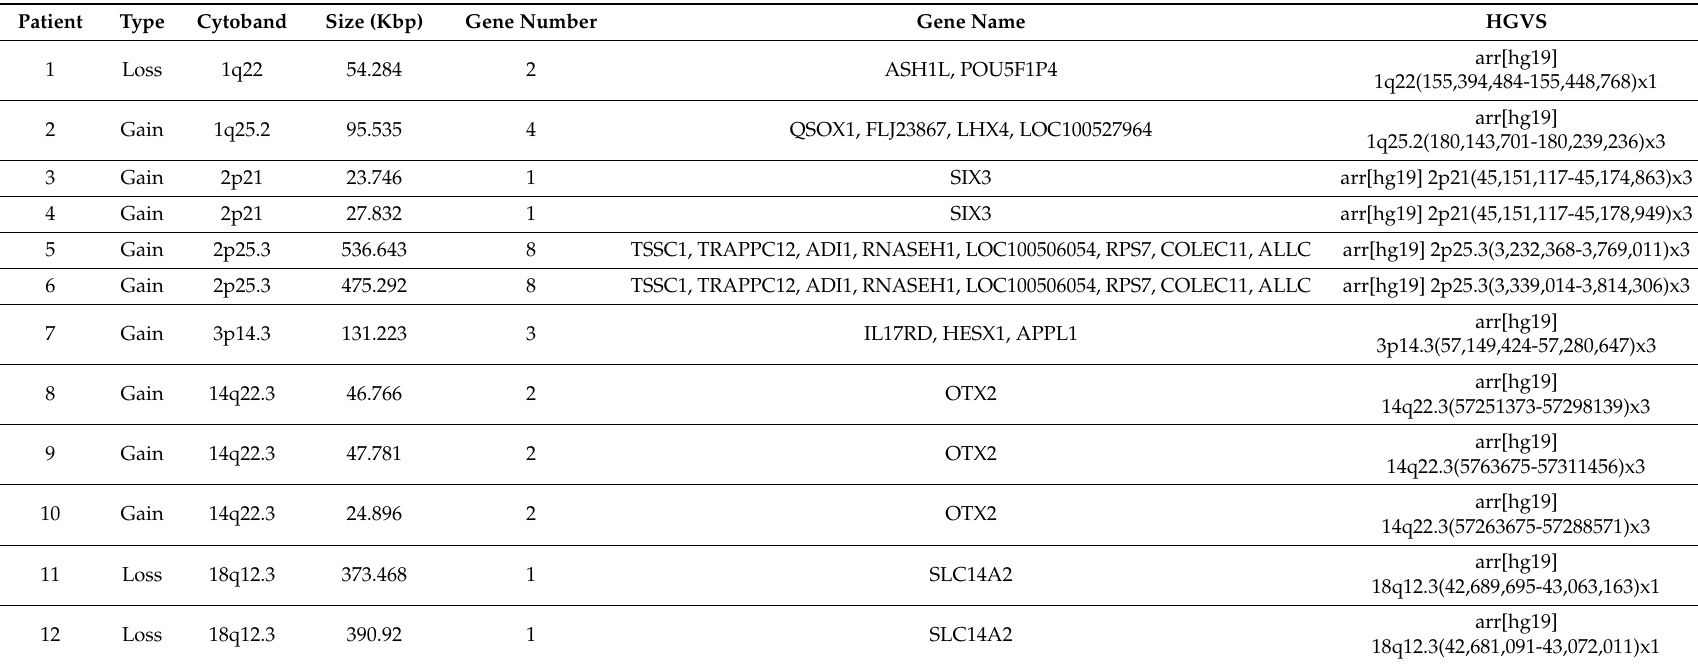
Table 1. Genomic regions identified in CPHD